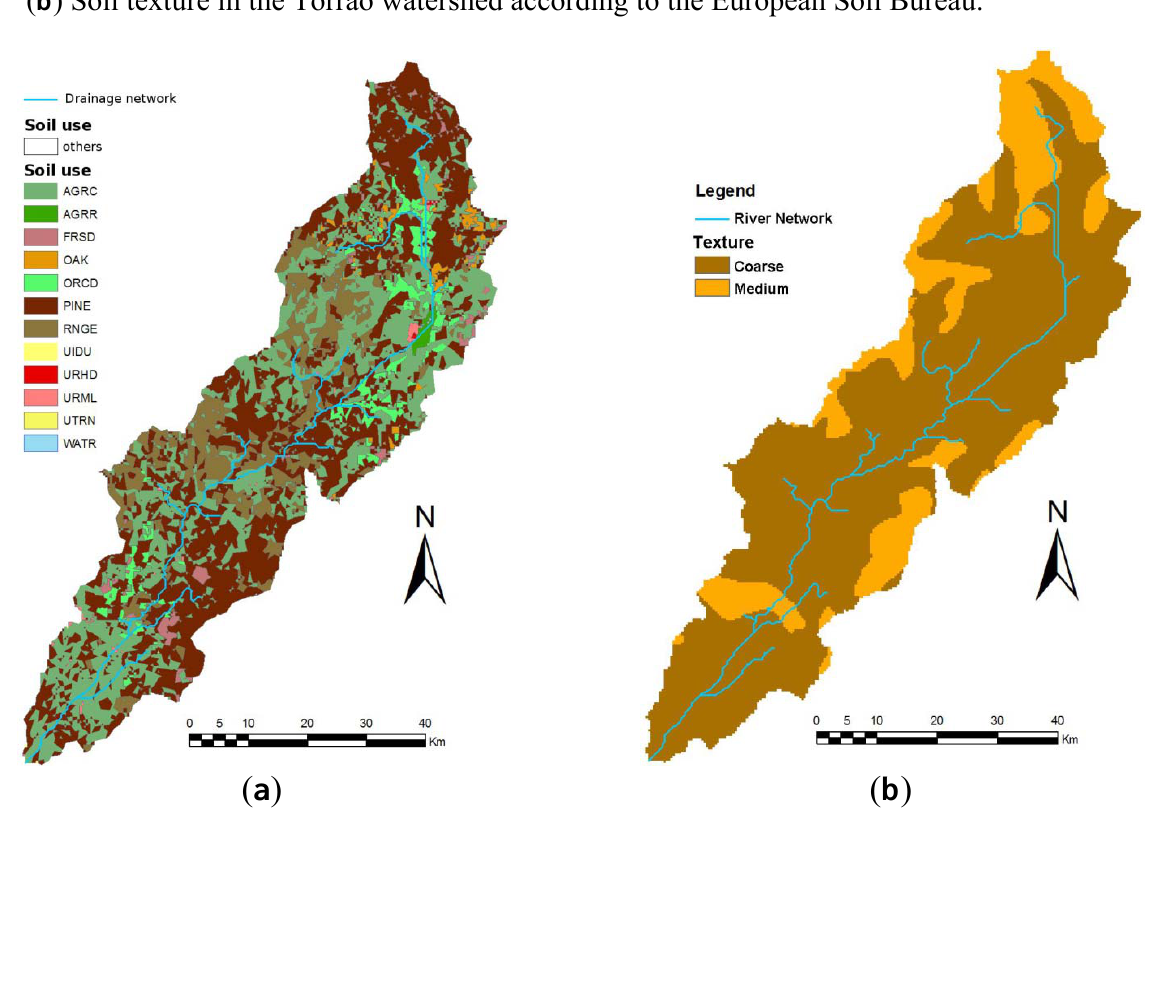
( b ) Soil texture in the Torrão watershed according to the European Soil